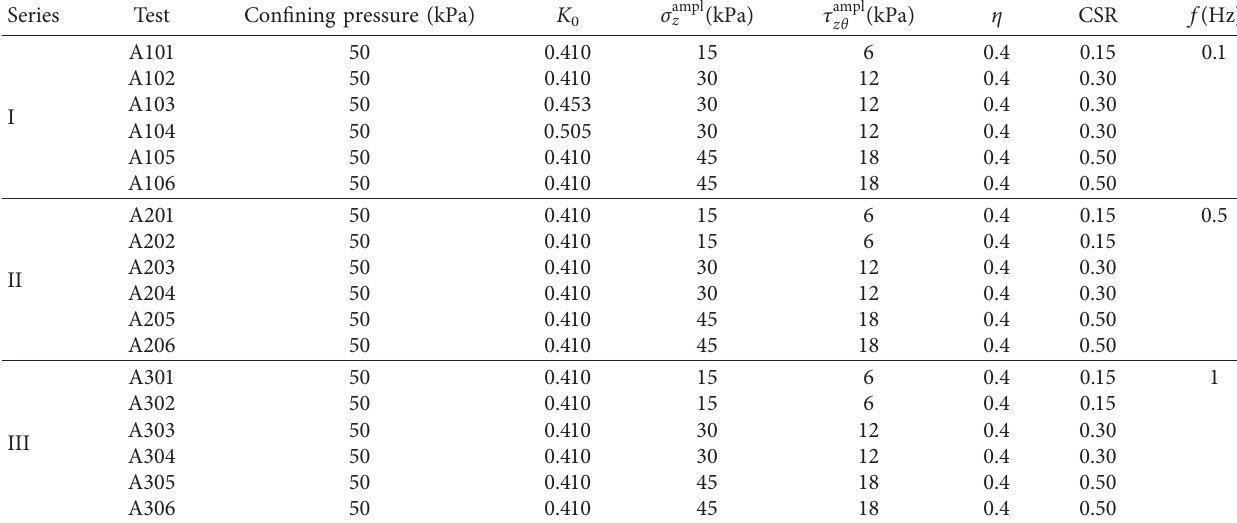
Table 3: Test plan.